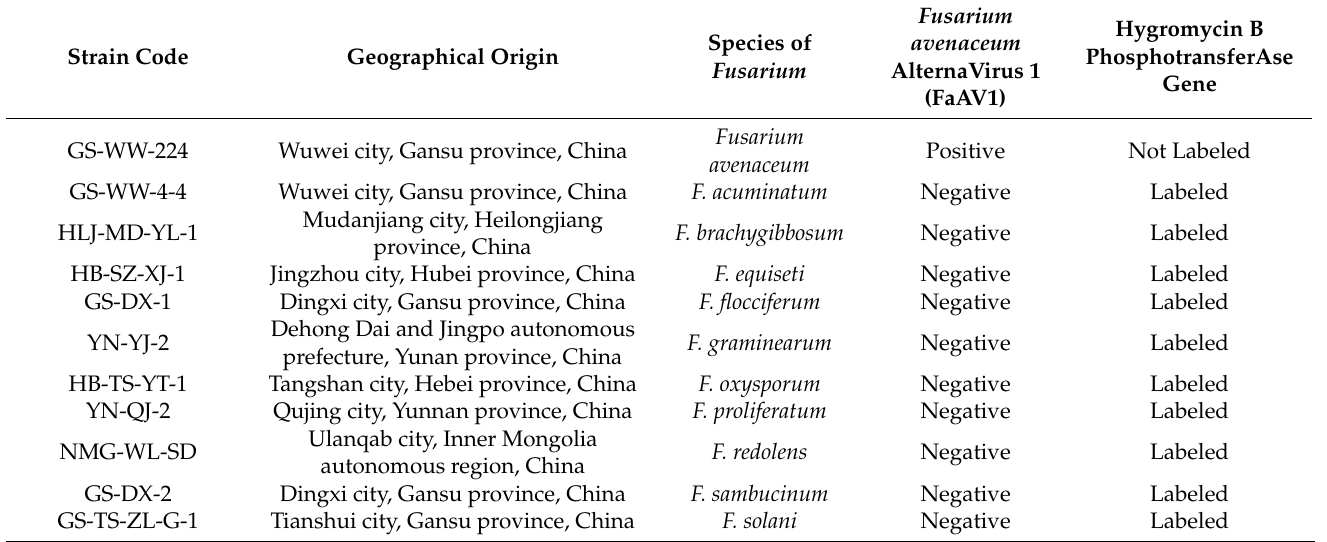
Table 1. Fusarium strains used in this